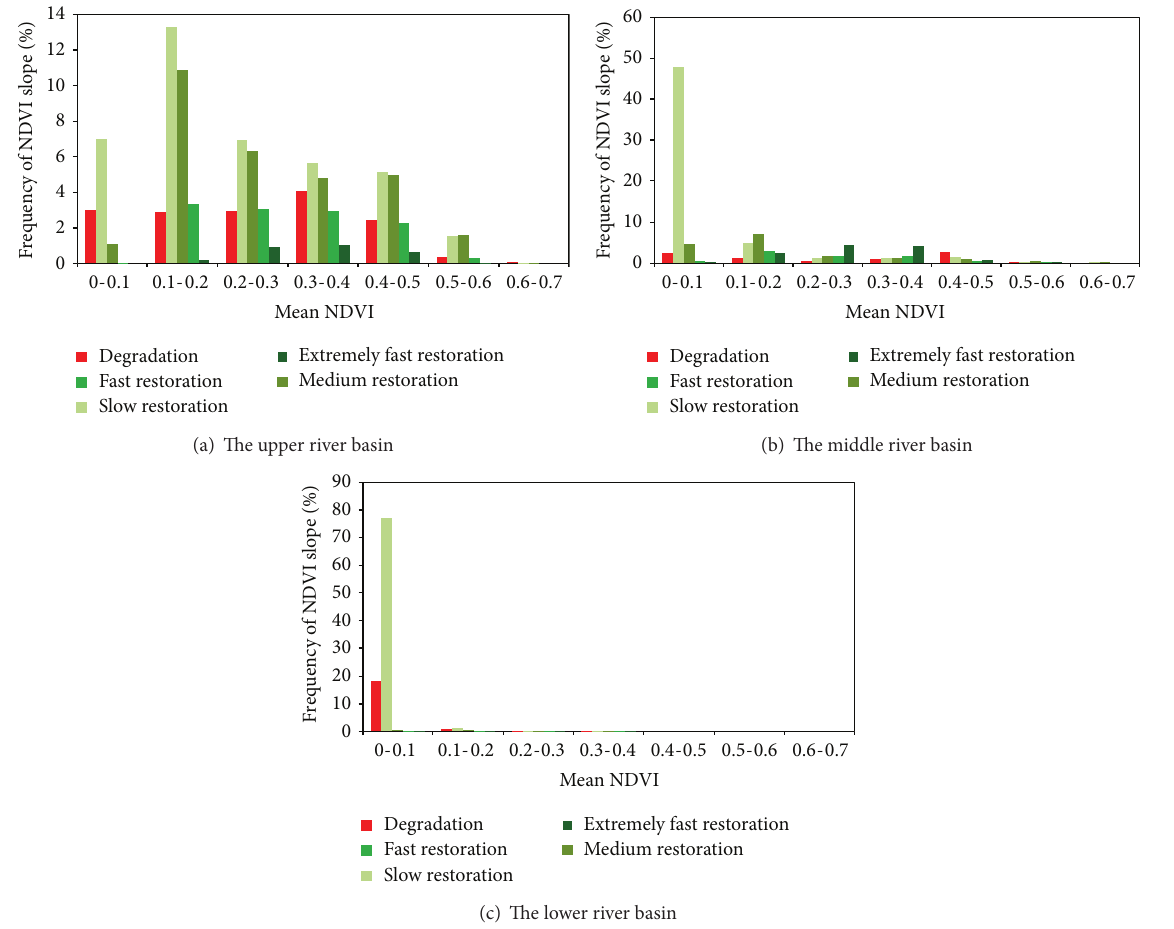
Figure 6: Frequency distribution of NDVI slope with mean